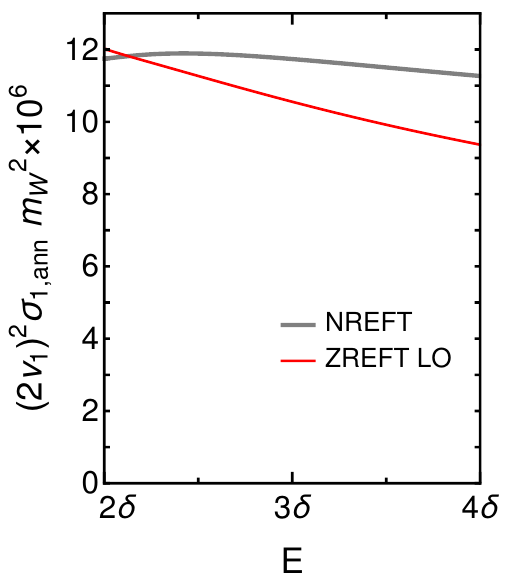
Figure 23 . Charged-wino annihilation cross section (cid:27) 1 ; ann multiplied by two powers of the relative velocity as a function of the energy E . The annihilation rate at the unitarity mass M (cid:3) = 2 : 39 TeV is shown for NREFT (thicker grey curve) and for ZREFT at LO (red